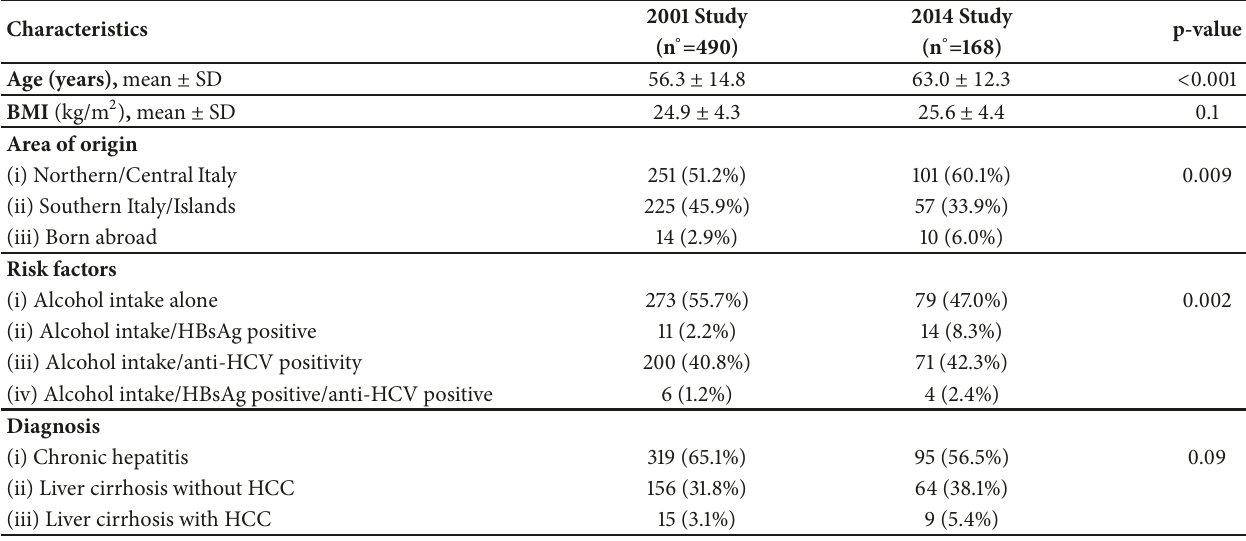
Table 4: Characteristics of chronic liver diseases alcohol related in female sex over time, in